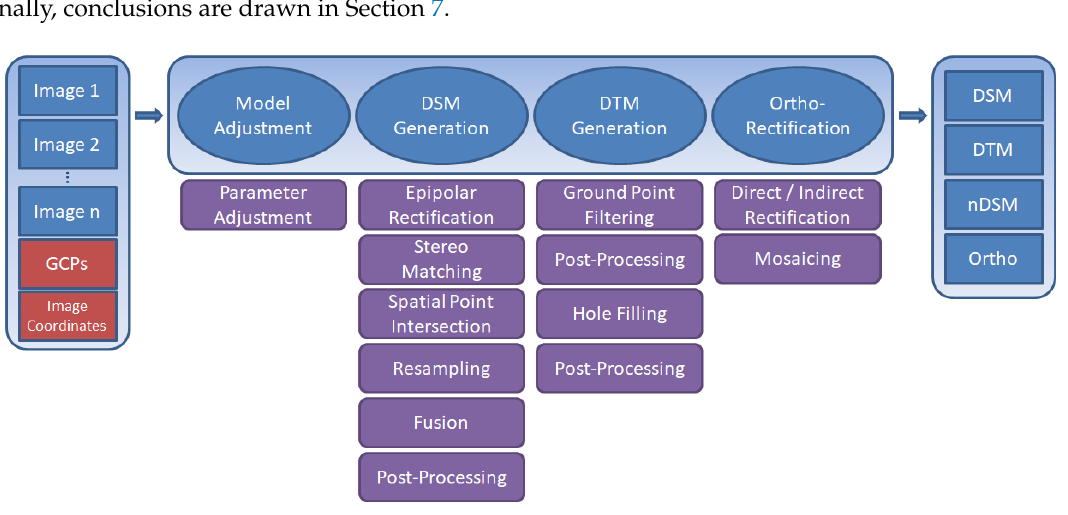
Figure 1. Proposed end-to-end 3D mapping workflow for multi-view stereo Pléiades images. The four core tasks are subdivided into according sub